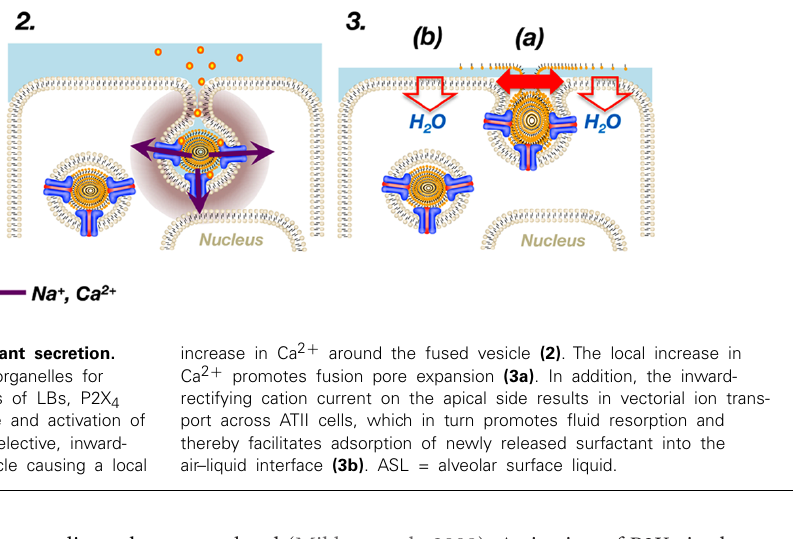
FIGURE 1 | P2X 4 receptors on LBs modulate surfactant secretion. P2X 4 receptors are expressed on LBs, large storage organelles for pulmonary surfactant in ATII cells (1) . Upon exocytosis of LBs, P2X 4 receptors readily become part of the apical membrane and activation of P2X 4 by extracellular ATP results in a transient, non-selective, inward- rectifying, cation current at the site of the fused vesicle causing a local